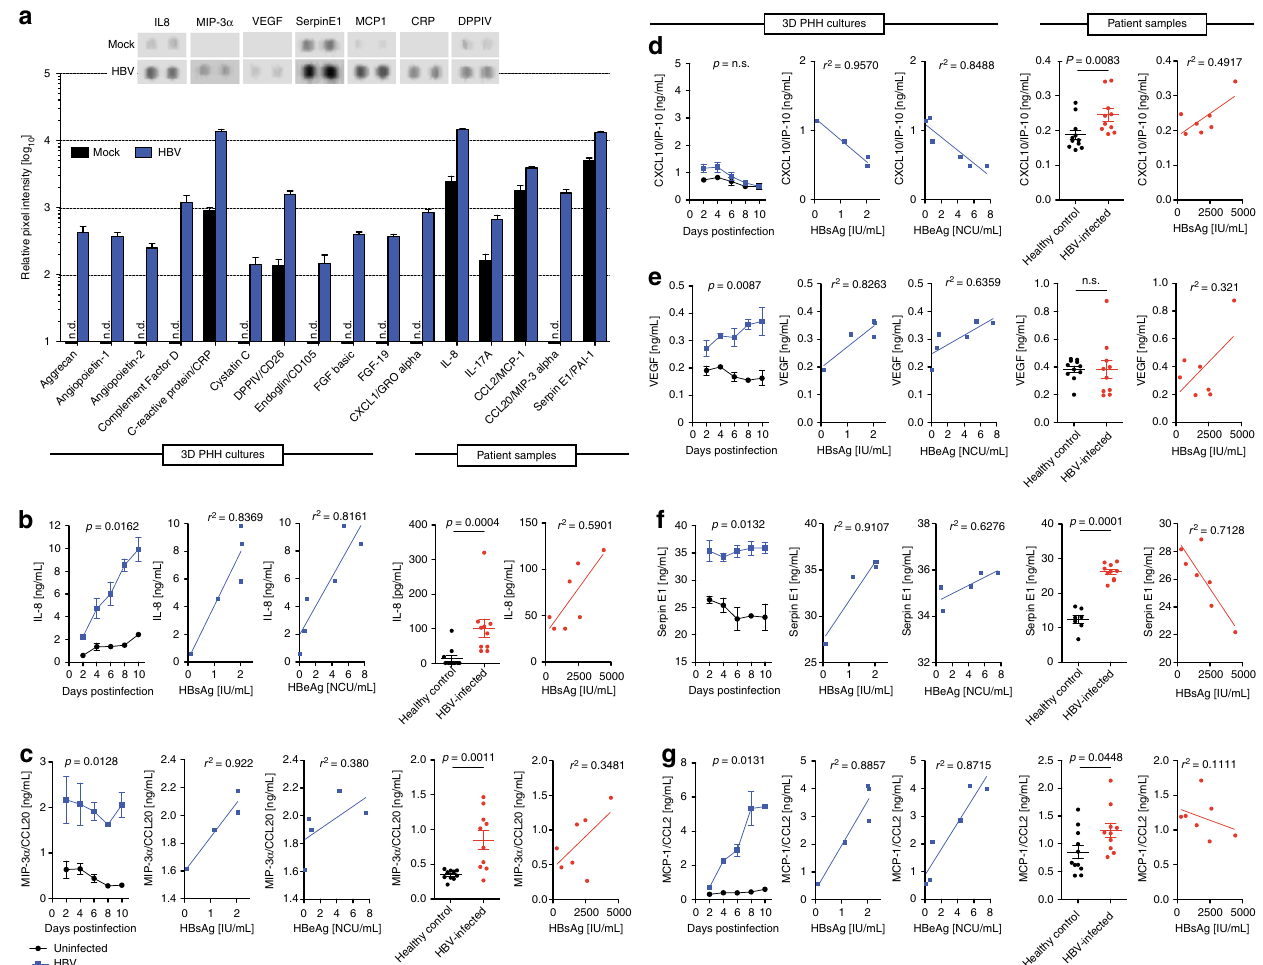
Fig. 5 HBV-infected 3D PHH cultures predict human host responses. a Cytokine XL antibody array of uninfected 3D PHH cultures and cultures infected with 100 GE/cell patient-derived HBV for 10 days. b – g Comparison of the longitudinal protein expression values of b IL-8, c MIP-3 α , d CXCL10, e VEGF, f Serpin E1, and g MCP-1 between HBV-infected patients, healthy controls, and 3D PHH cultures infected with patient-derived HBV (100 GE/cell) as well as correlation of each cytokine with HBsAg (HBV-infected patients and infected 3D PHH cultures) and HBeAg (infected 3D PHH cultures) levels. Data shown are mean ± SD of three independent experiments. p -values calculated by two-way ANOVA with Bonferroni